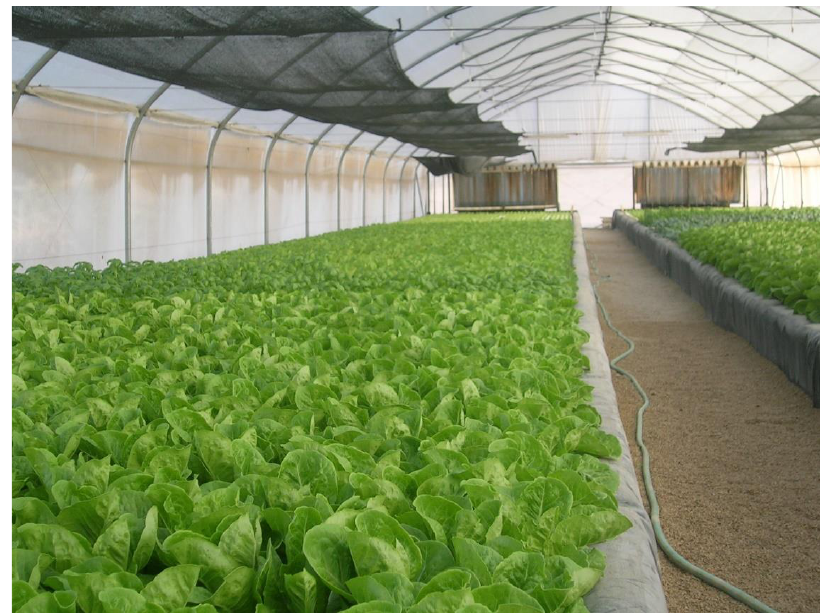
Figure 3. Hydroponically grown Romaine lettuce on an Israeli farm. Photography by E. Shalgi.